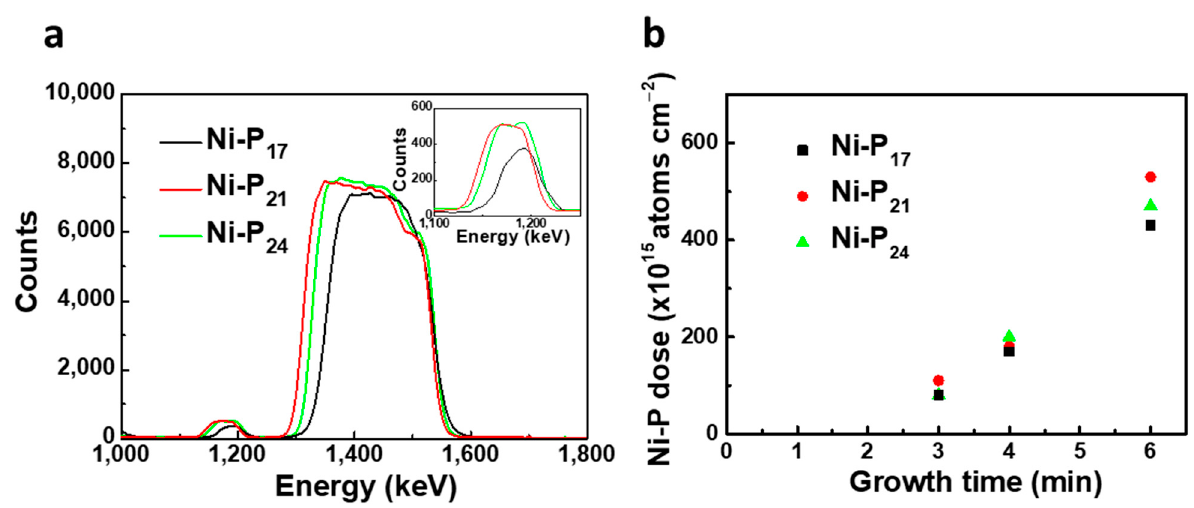
Figure 2. ( a ) Comparison of RBS spectra of Ni–P coatings with different phosphorus concentrations grown for 6 min. The inset reports a zoom in on the region of phosphorus. ( b ) Plot of the dose of Ni–P as a function of the growth time.